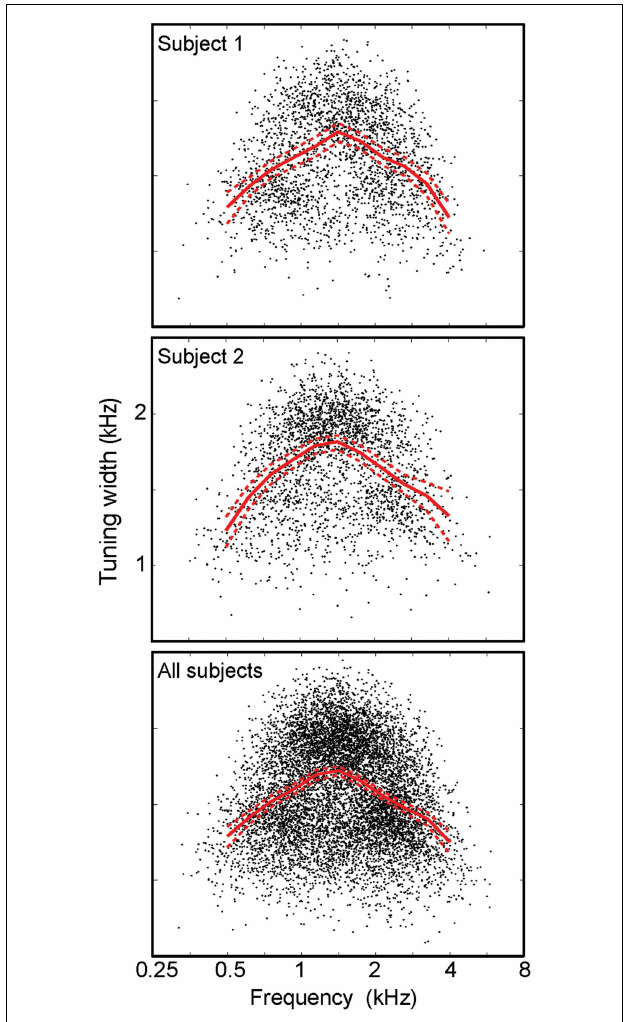
FIGURE 6 | Frequency tuning width vs. centroid frequency . Points (black) for individual voxels plotted with a regridded average (red) with bootstrapped confidence intervals all display an “inverted-U”